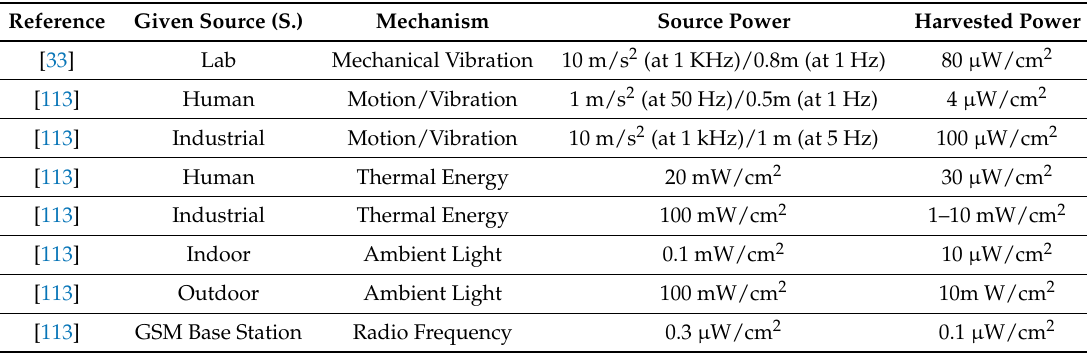
Table 3. Energy sources for IoT